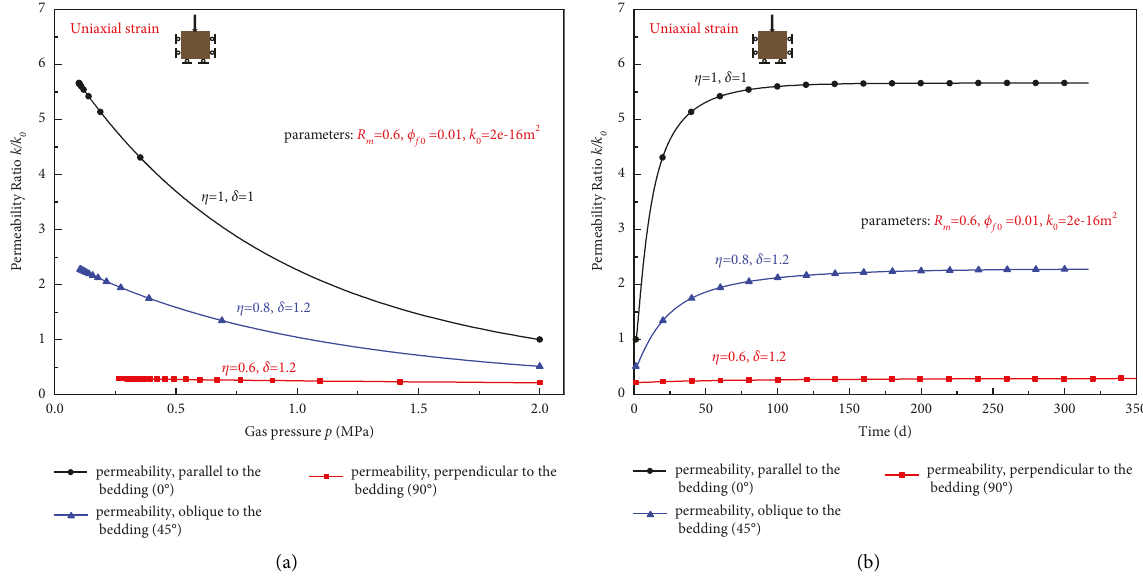
Figure 11: Coal permeability ratio as a function of (a) gas pressure and (b) time under uniaxial strain